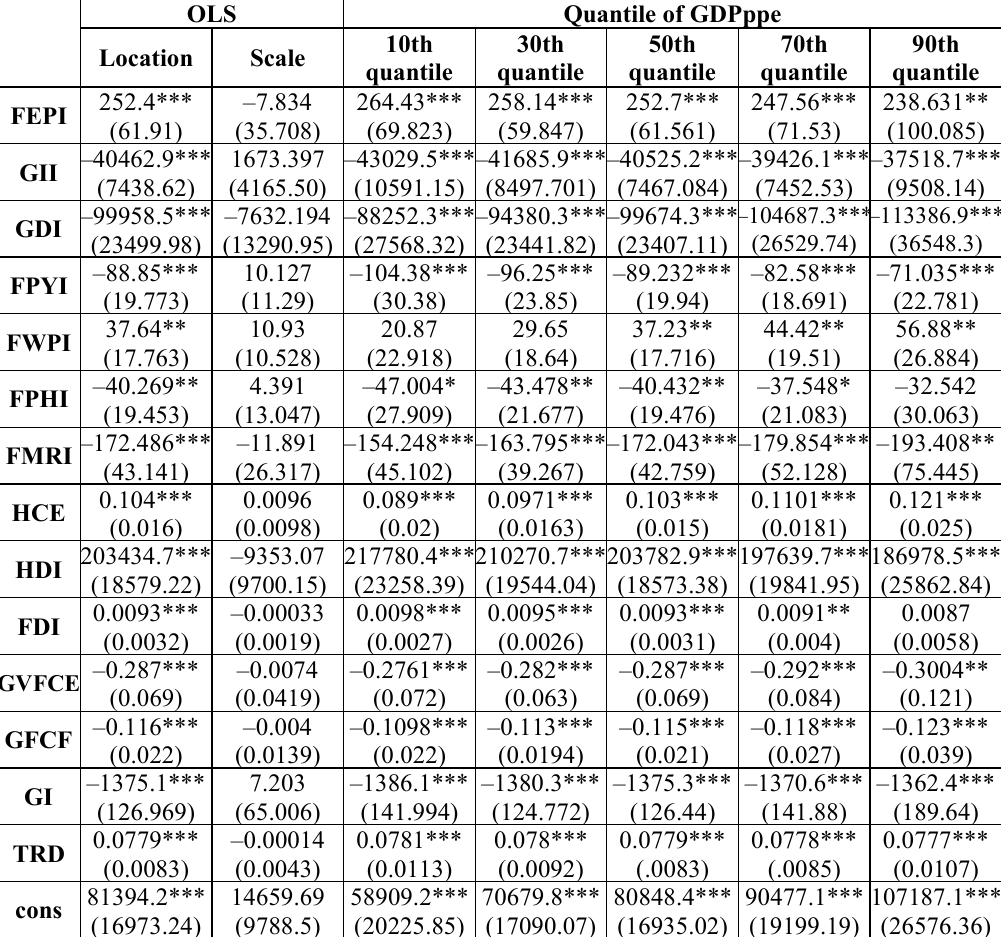
Table 2. Results of Panel Quantile Regression with Fixed Effects